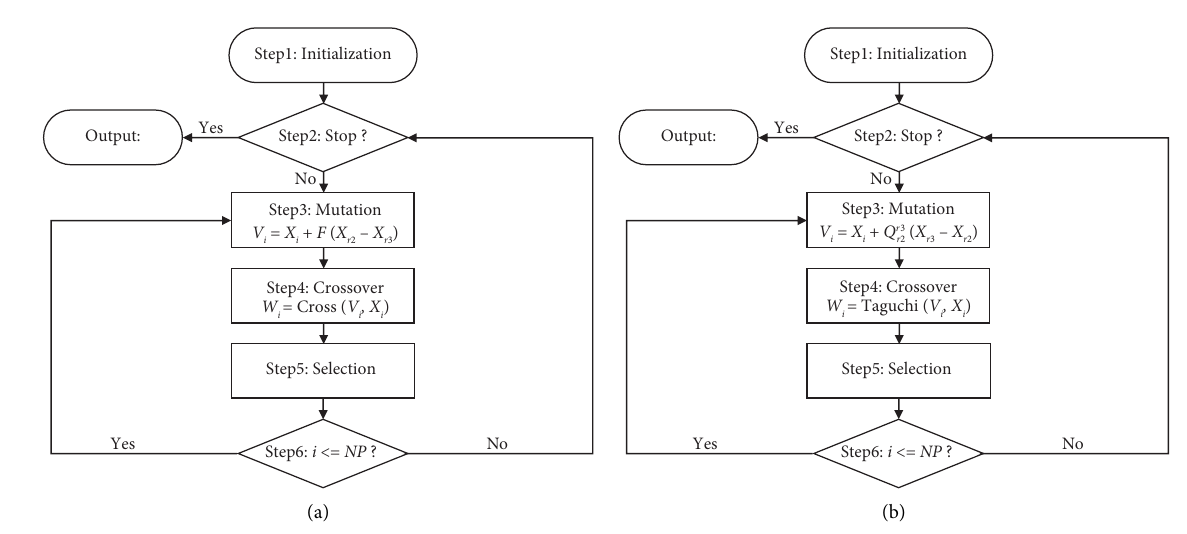
Figure 4: Flowcharts of DE and DE\FCr2. (a) DE. (b) DE\FCr2.